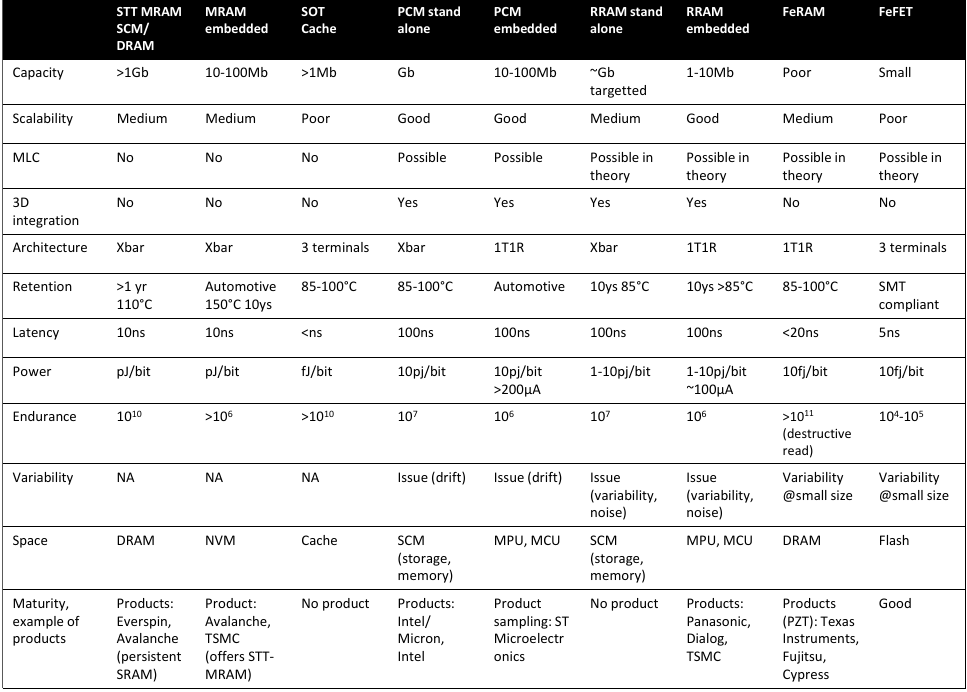
Figure 6. Tentative benchmark of various emerging memory technologies for various applications.